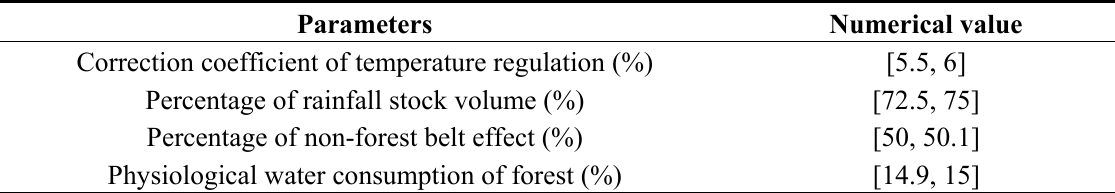
Table 5. Other technical parameters of the CDM forestry